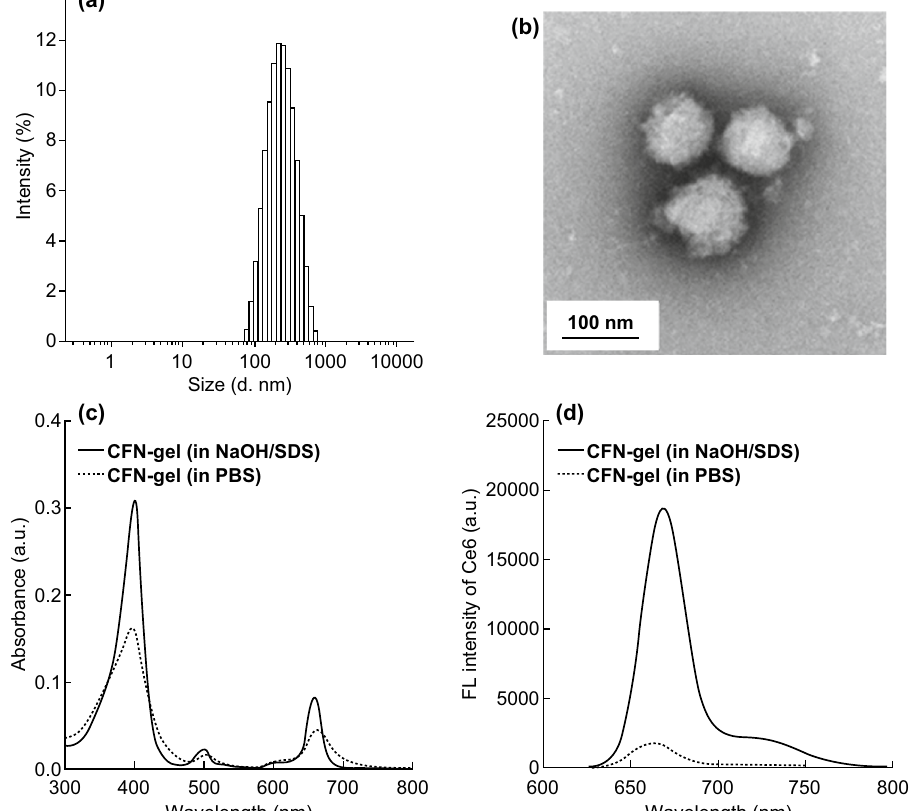
Fig. 2 Characterization of CFN‑gel. a Hydrodynamic size distribution of CFN‑gel, b TEM image of CFN‑gel, c UV/Vis absorption spectra of CFN‑gels in surfactant‑containing (0.1 M NaOH/1% SDS) (solid line) and PBS (dotted line) solutions at a 2 µM Ce6 equivalent, d fluorescence spectra ( λ ex 400 nm) of CFN‑gel in surfactant‑containing (solid line) and PBS (dotted line) solutions at 2 µM Ce6